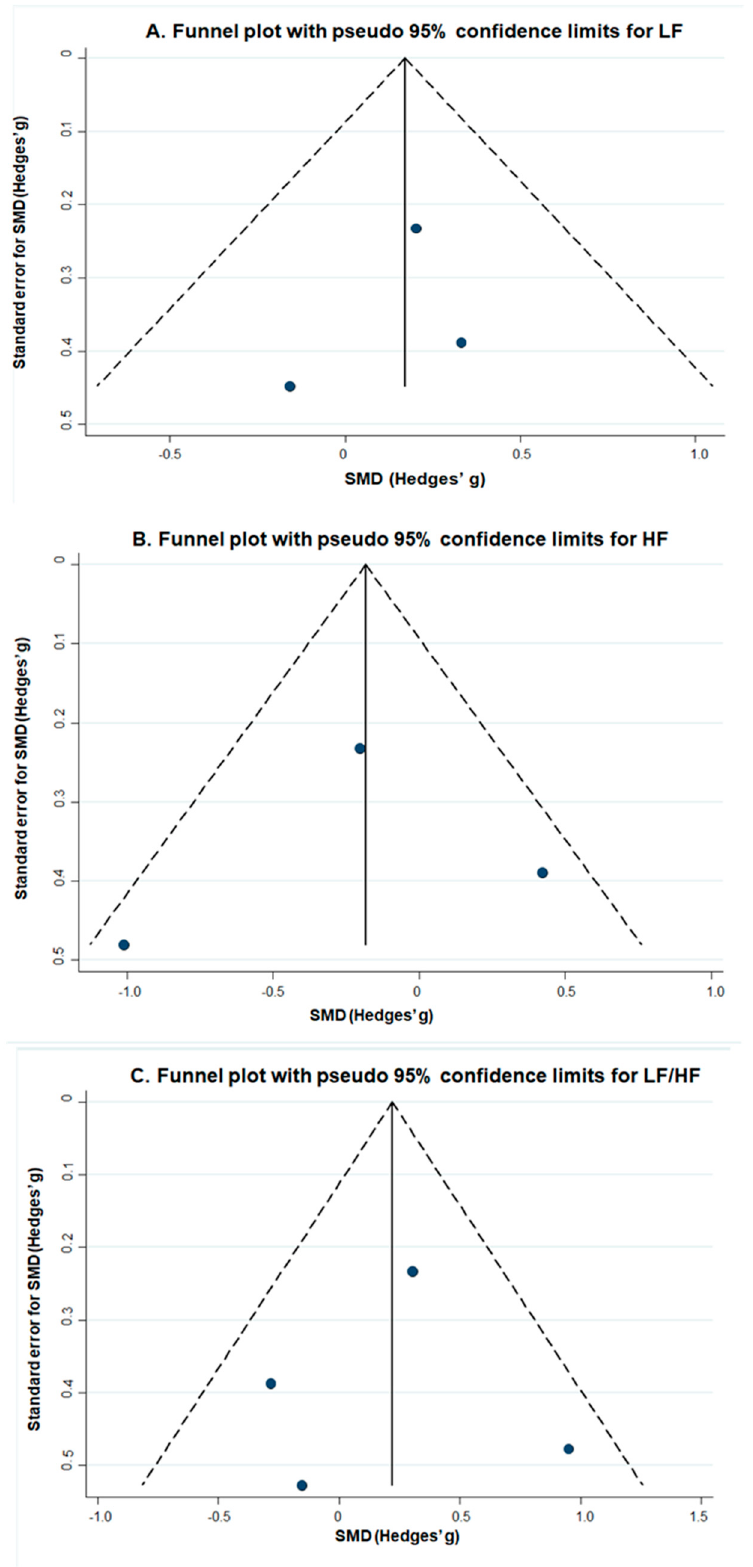
Figure A2. Funnel plots of standard error for Hedges’ g effect sizes for frequency domain heart rate variability parameters: ( A ) low frequency (LF), ( B ) high frequency (HF), and ( C ) LF/HF ratio.